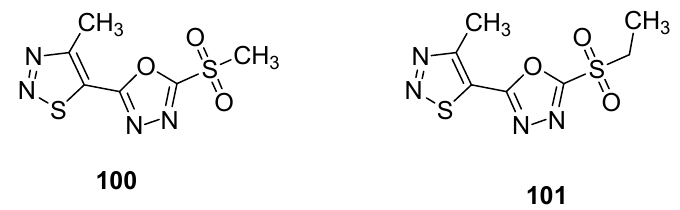
Figure 9. 1,2,3-thiadiazoles 100 – 101 with anti-TMV activity. Other promising anti-TMV agents 102 and 103 were presented by Zheng et al. (Figure 10) [83]. The substituted 1,2,3-thiadiazole-4-carboxamide scaffold 102 exhibited the best antiviral curative activity of 60 and 47%, at 500 and 100 µ g/mL concentrations, while the standard tiadinil showed curative activity 58 and 46% at 500 and 100 µ g/mL concentrations, respectively. Compound 103 showed its potent protective effect 76 and 71% at 500 and 100 µ g/mL concentrations in comparison with the standard drug tiadinil, which displayed protective 75 and 57% at 500 and 100 µ g/mL. The structure 103 marked a higher protective effect than the tiadinil and 102 at 100 µ g/mL concentration. The enhanced protective potential of 103 was dose-dependent and due to the presence of hyroxyphenyl moiety. The fluorophenyl, chlorophenyl and hyroxyphenyl functionalities contributed to better efficacy that led to a future investigation to develop promising anti-TMV agents